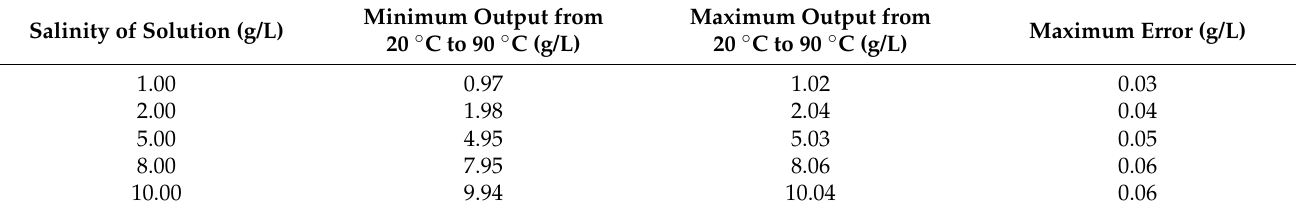
Table 4. Accuracy of the test data.